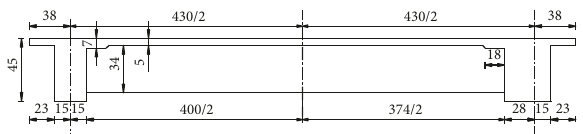
Figure 5: Cross-sectional view of the main beam of the